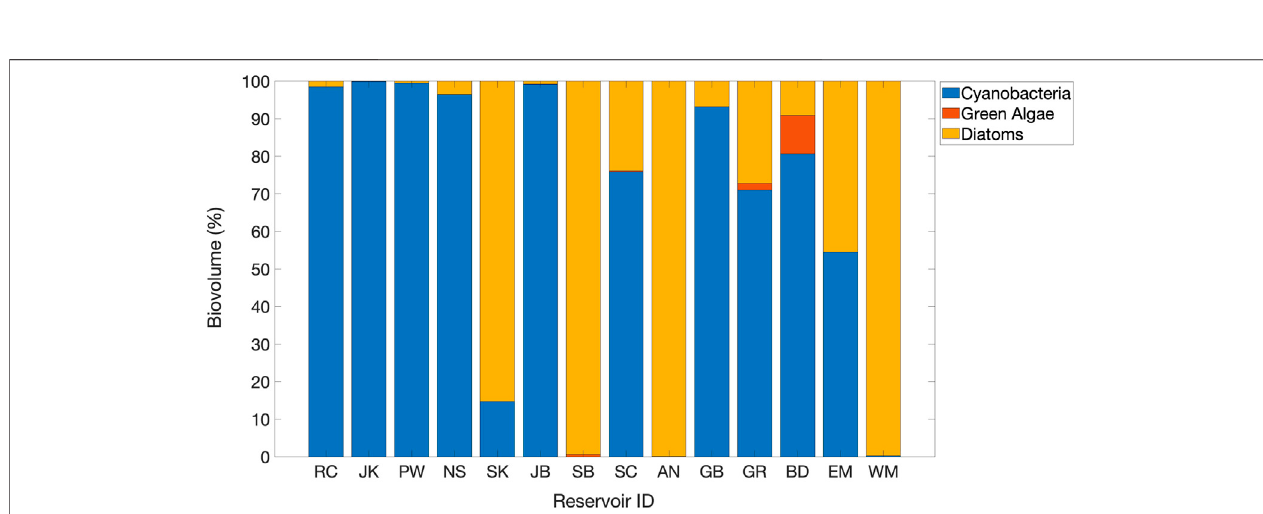
FIGURE 4 | Distribution of phytoplankton Biovolume % of 14 reservoirs identi fi ed by the FlowCAM. Reservoirs are arranged from highest TOC (11.5 mg/L) on the left to lowest TOC (2.5 mg/L) on the right. RC, SK SB, SC, AN GB, GR and EM are mountain reservoirs. JK, PW, NS, JB, BD and WM are plains reservoirs.